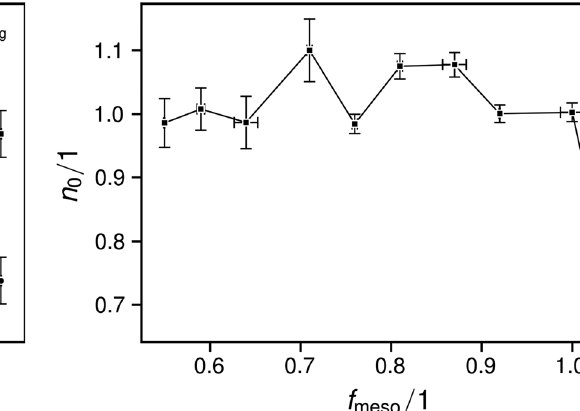
Figure 6: High - temperature limits of the fl ow behaviour indices.